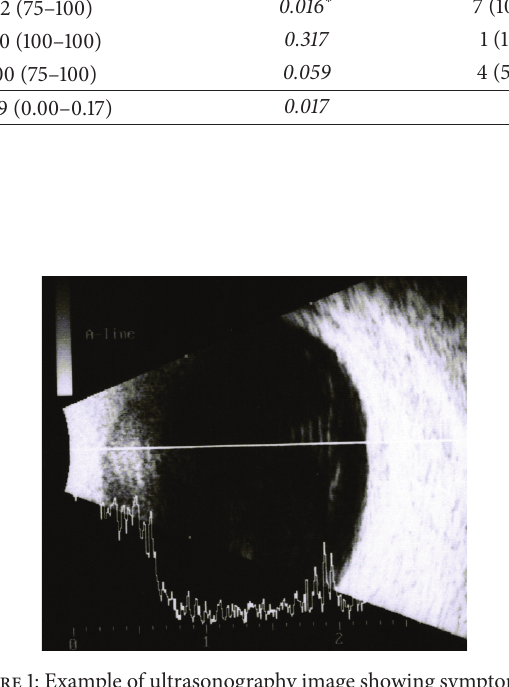
Figure 1: Example of ultrasonography image showing symptomatic PVD in one eye 7 months after multifocal IOL implantation in a patient complaining of floaters, halos, and poor quality of vision.